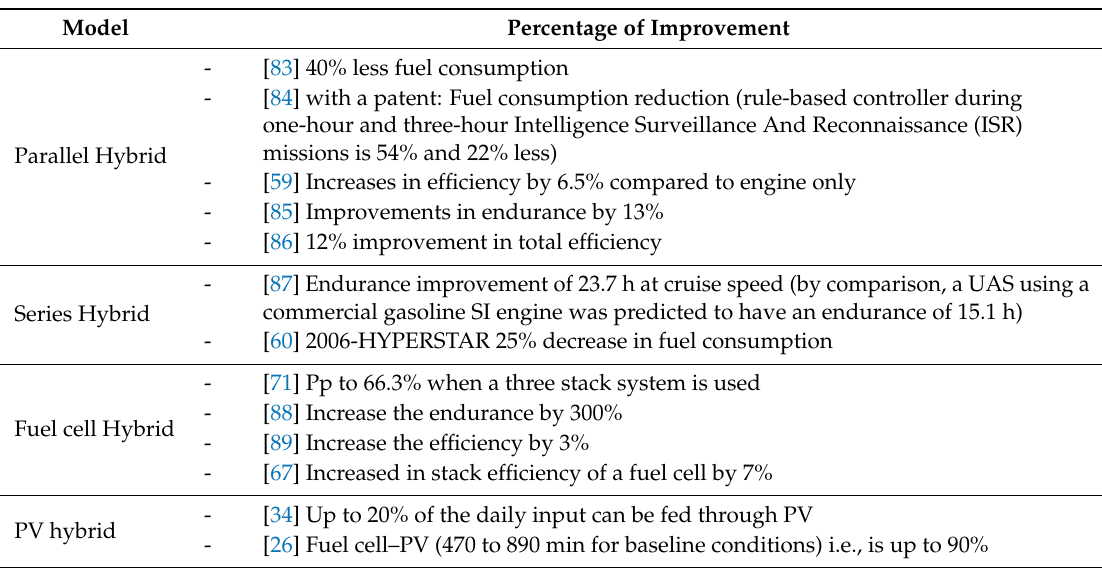
Table 2. Comparison of different hybrid systems and percentage of